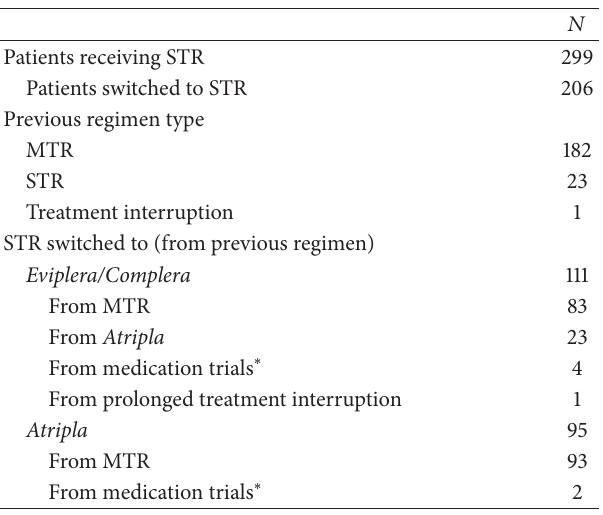
Table 1: Disposition of ARV switch to STR.